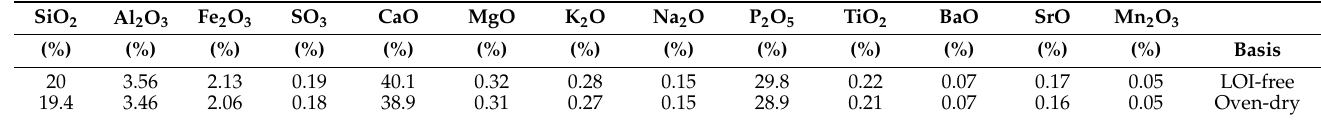
Table 2. Chemical composition of BPR determined by X-ray fluorescence